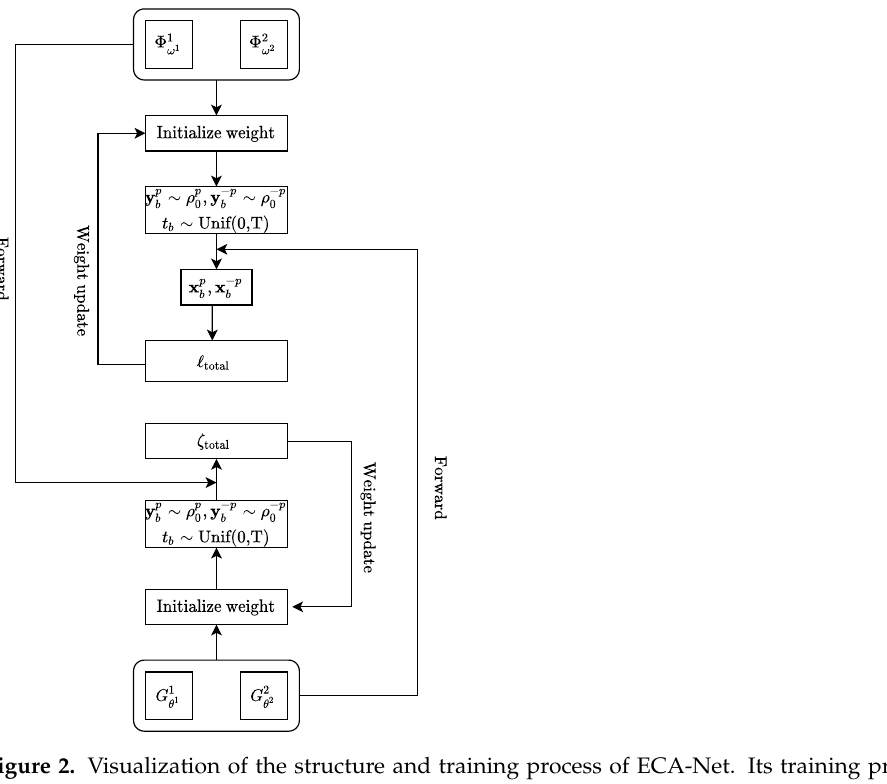
Figure 2. Visualization of the structure and training process of ECA-Net. Its training process is divided into two pairs of coupled alternating training parts—generators and